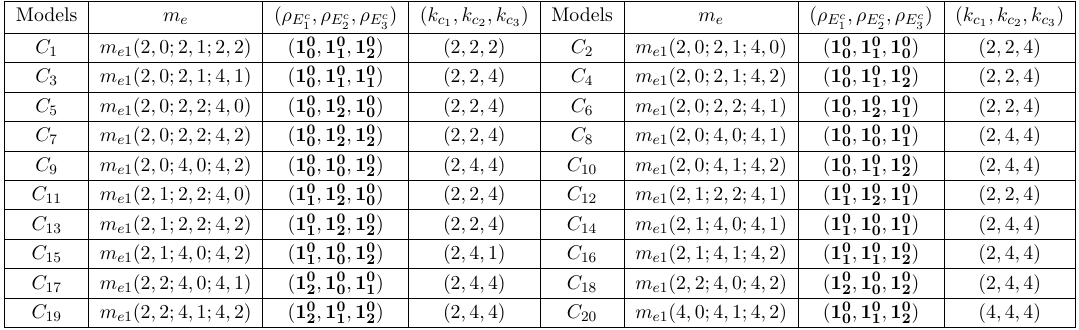
Table 3 . The 20 possible charged lepton mass matrices and the corresponding representations and modular weights of charged leptons for the type I models, where k c the modular weight of the charged lepton